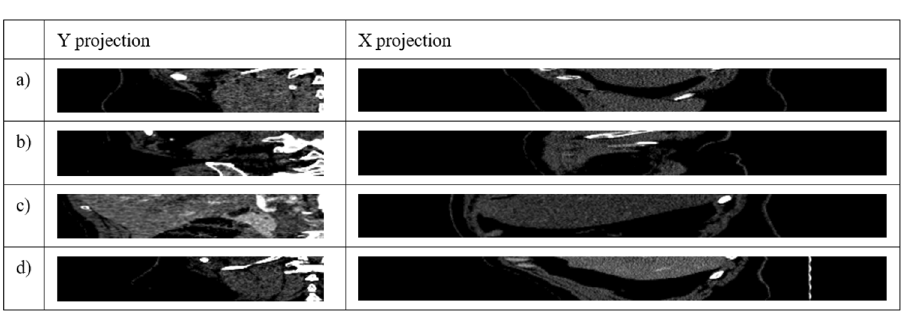
Figure 9. Example of four random images in X and Y projection for class BC generated by our solution.